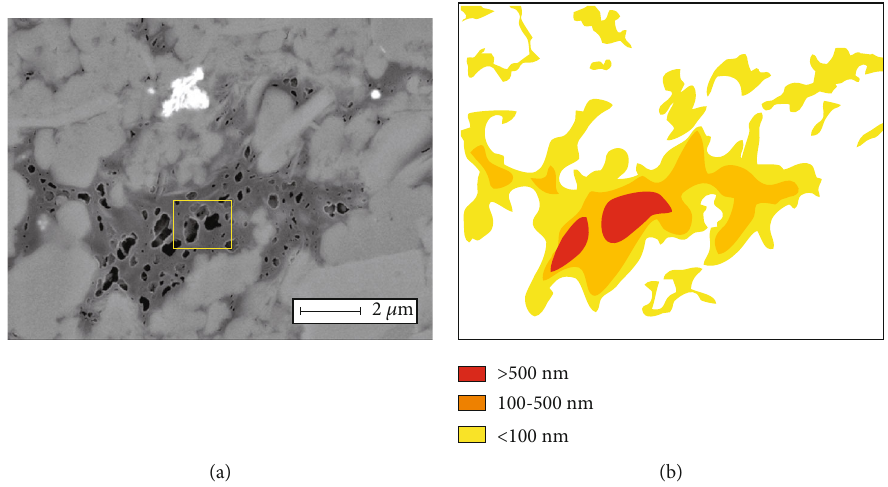
Figure 18: Characteristics of the pyrobitumen pores based on 2D FIB-SEM data. (a) The large pores are concentrated at the center of the pyrobitumen. (b) Pattern of fi gure